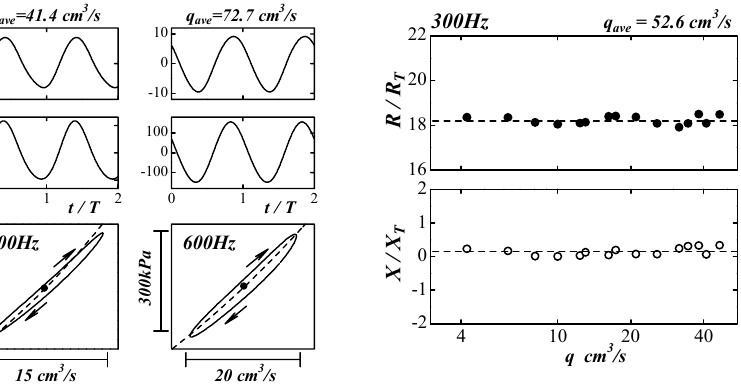
Fig.7 Nonlinear behavior of orifice impedance in a reciprocating oil flow with zero average